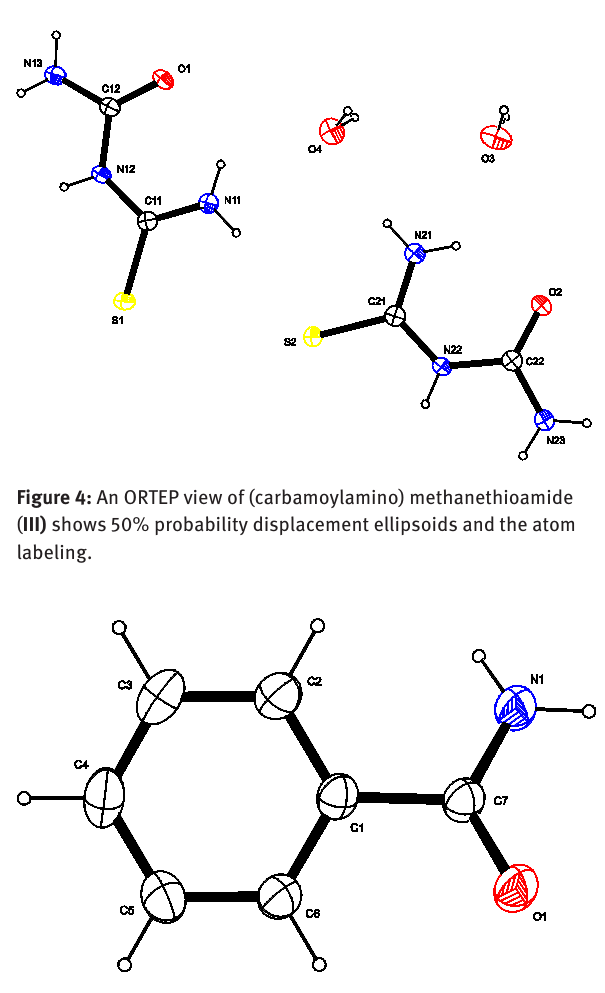
Figure 5: An ORTEP view of benzamide ( V ) shows 50% probability displacement ellipsoids and the atom labeling.